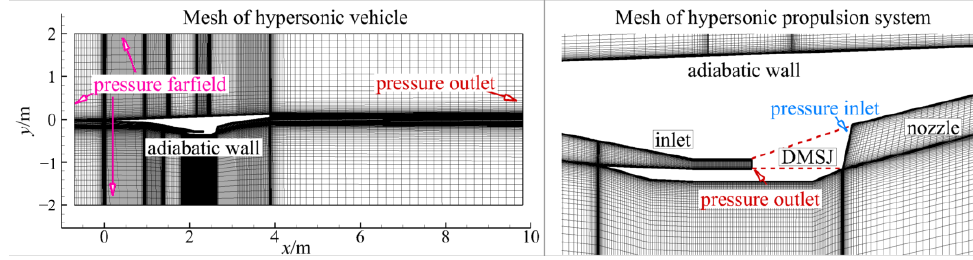
Figure 3. Mesh and boundary conditions of the investigated hypersonic vehicle.